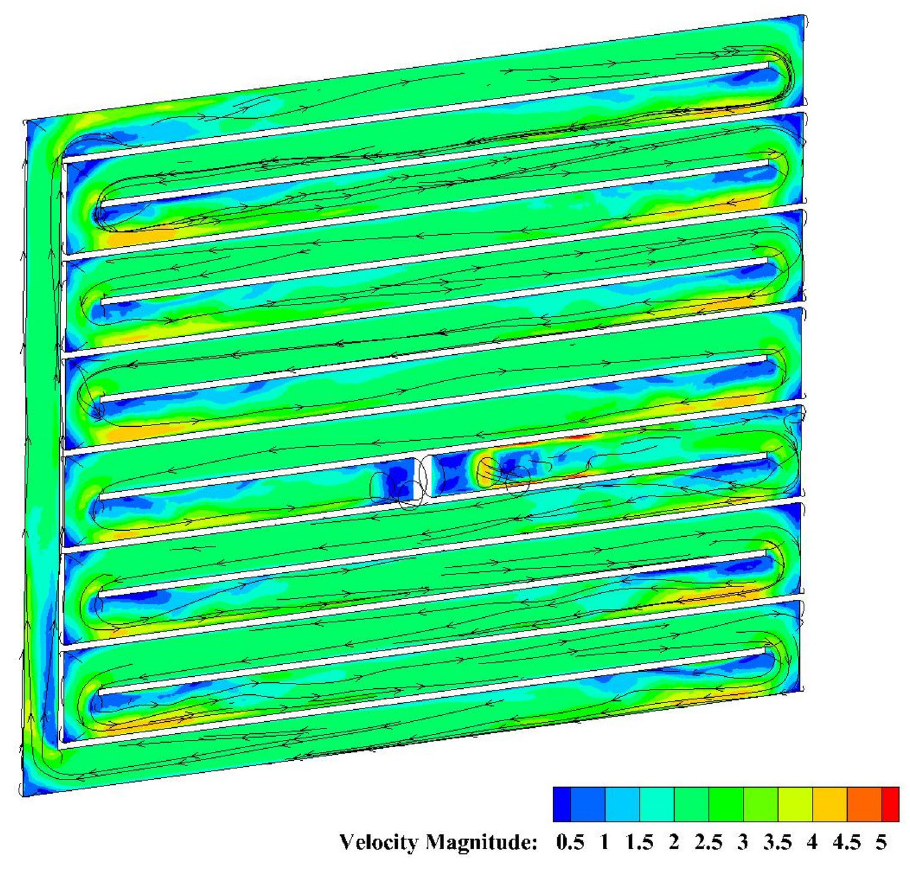
Fig. 26 Detailed streamlines near the elbows and bends at 10